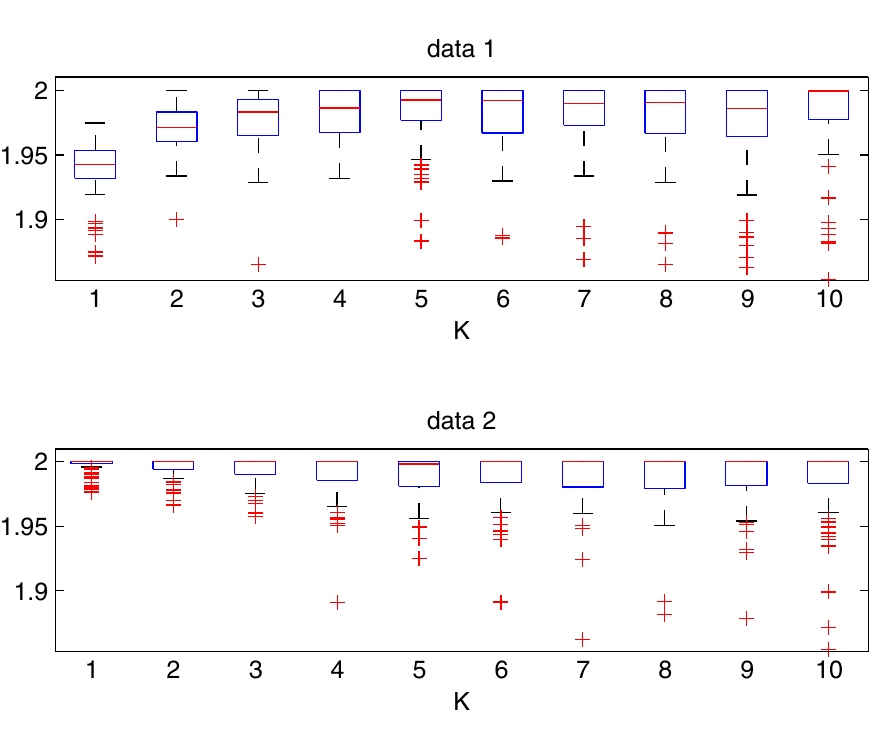
Fig 12. Estimated α values for the data1 from the top left panel of Fig 11 (top panel) and for the data2 from the top right panel of Fig 11 (bottom panel). The box plots were constructed from 100 bootstrap samples of length